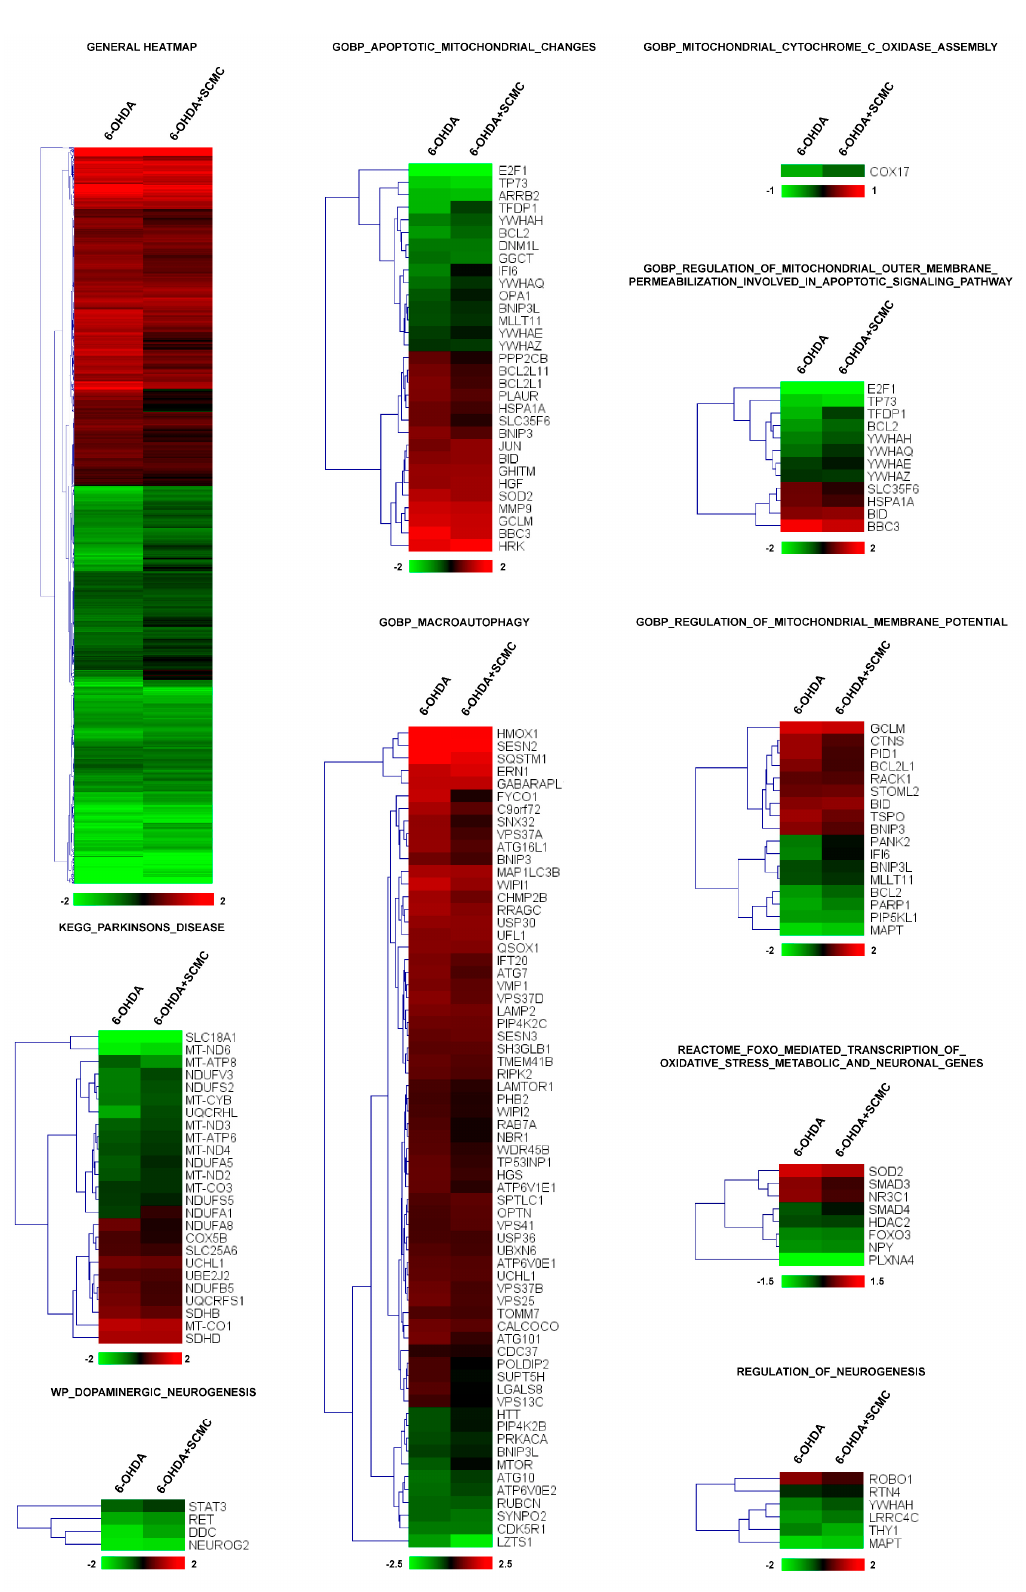
Figure 1. Heatmap of hierarchical clustering of the selected pathways. All the genes of the pathway that are significantly affected by 6-OHDA (adjusted p < 0.05) are reported in the heatmaps. Color scale represents log2 ratios of the expression levels in the indicated condition versus control. Color scale limits are indicated in the lower